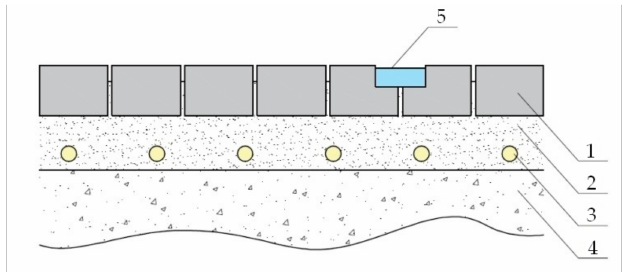
Figure 1. Cross section of the heating system: 1—outside surface, 2—sand and cement, 3—heating pipes, 4—hardened ground, 5—temperature and humidity